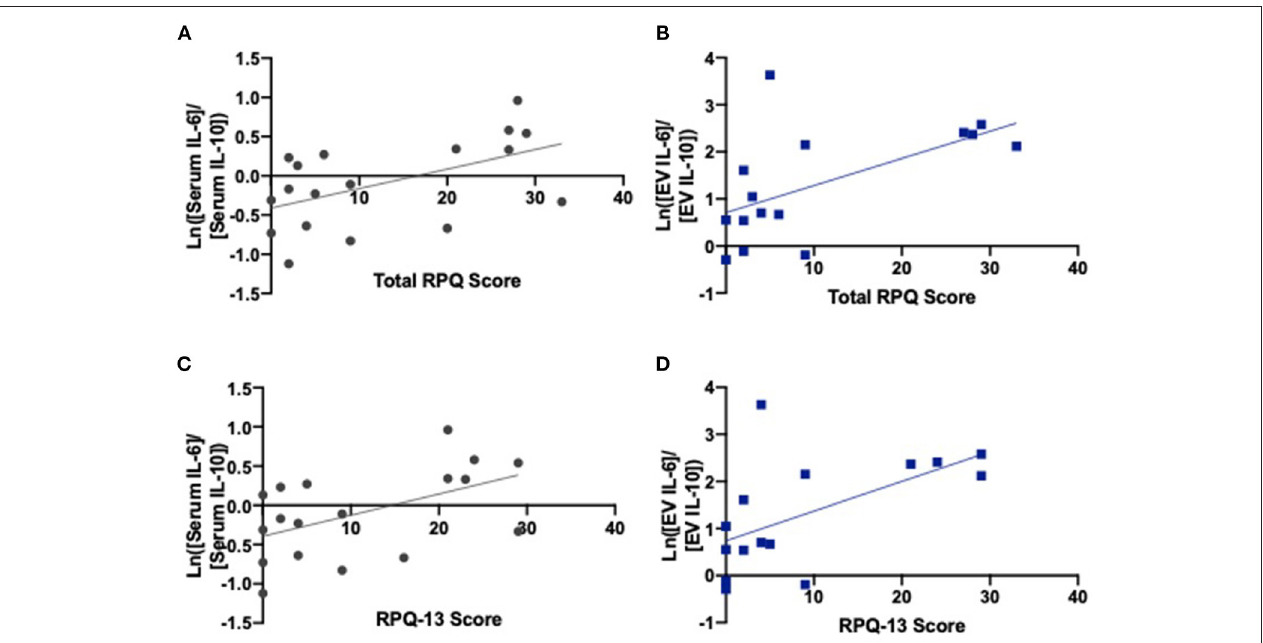
FIGURE 3 | IL-6/IL-10 ratios correlate with late postconcussive symptoms. (A) Serum ratios of IL-6/IL-10 ( r = 0.526, p = 0.025) and (B) EV ratios of IL-6/IL-10 correlate with total RPQ score ( r = 0.585, p = 0.022). (C) Serum ratios of IL-6/IL-10 ( r = 0.515, p = 0.029) and (D) EV ratios of IL-6/IL-10 correlate with RPQ-13 scores ( r = 0.580, p = 0.023), the portion of the exam related to late postconcussive symptoms. Graphs include line of best